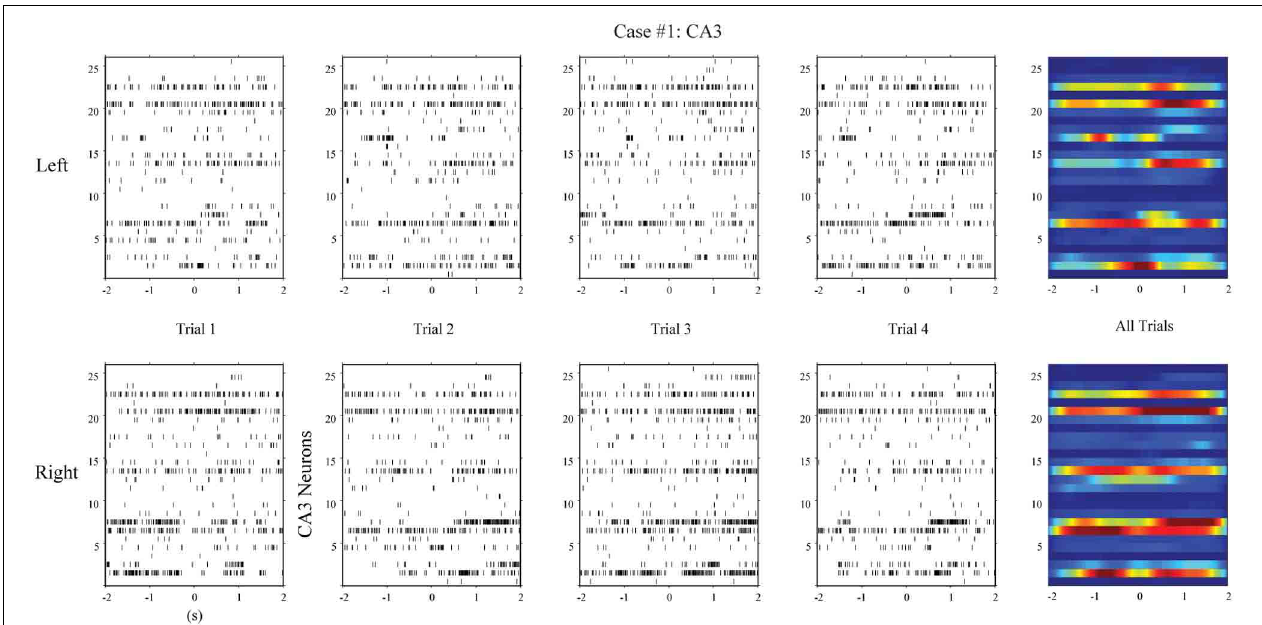
FIGURE 4 | Spatio-temporal patterns of spikes in the hippocampal CA3 (input) region during left and right sample events of the DNMS (case